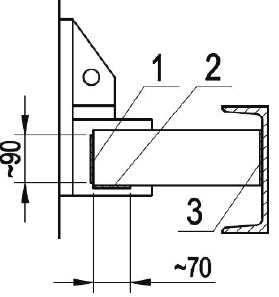
Fig. 3. Detail of connector welding: 1, 2 – fillet welds in the broken lap joint (1 – low quality Figure 3: Details of connector welding: 1 and 2, fillet welds in the double fillet weld